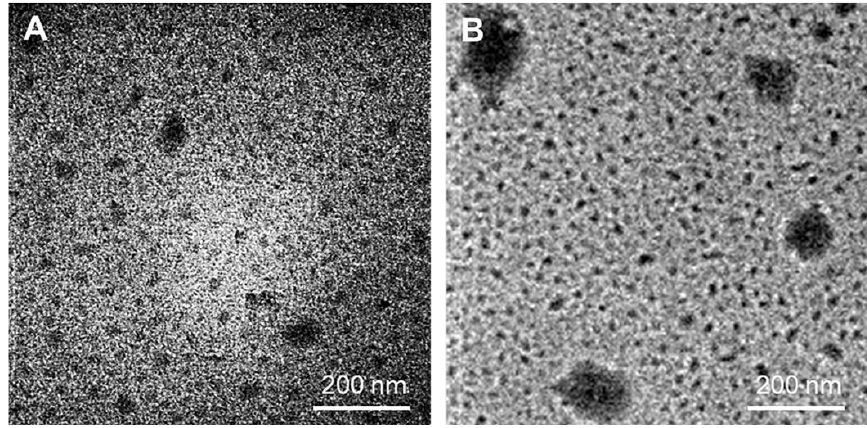
Figure 2. TEM image of polyamidoamine dendrimer PAMAM G4.0 ( A ) and oil/PAMAM G4.0 ( B ).